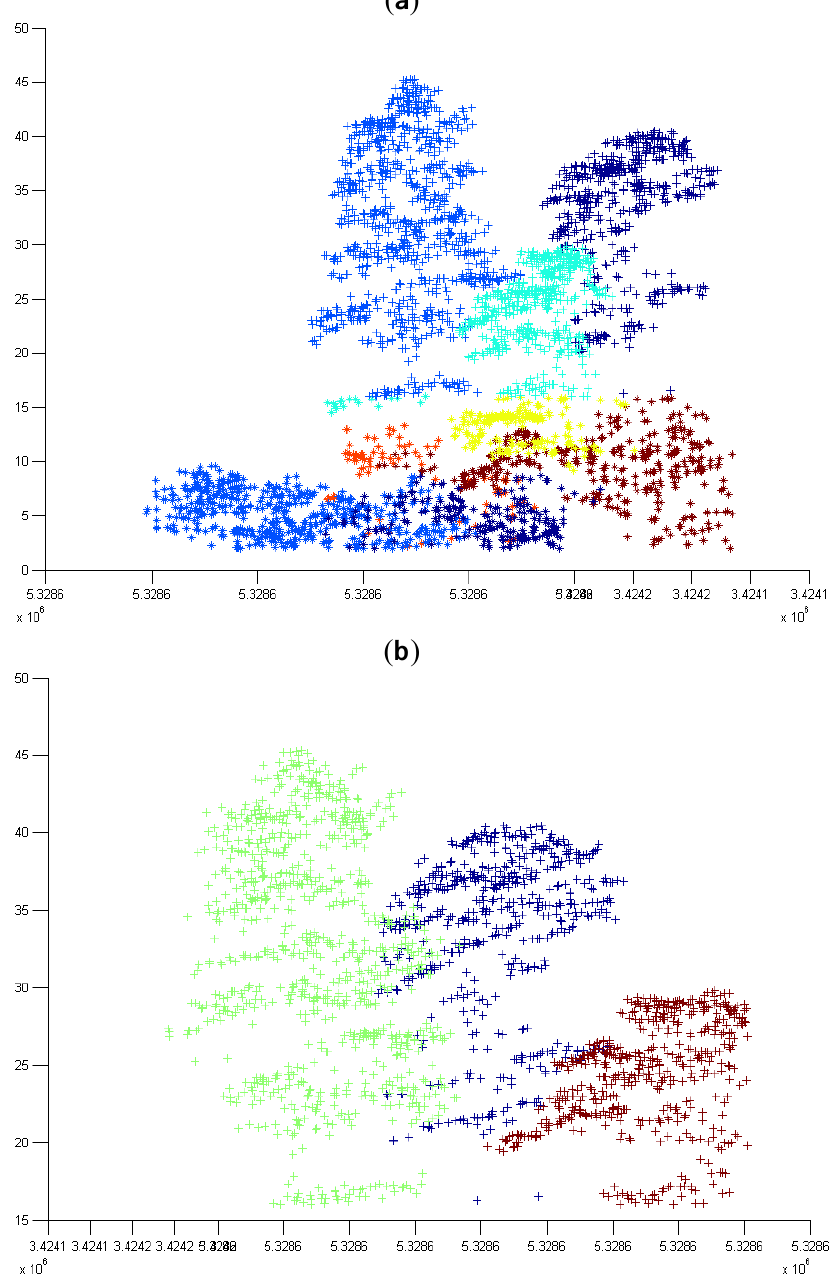
Figure 15. Result after running hierarchical tree clustering without scaling down the height value on two datasets of Cell 6 at different height levels. ( a ) Cell 6 clusters after hierarchical clustering in 2 height classes (between 2 and 16 m height and above 16 m height). ( b ) Cell 6 clusters after hierarchical clustering performed on dataset above 16 m height. The x and y coordinate values (in meters) are displayed horizontally and the z value (in meters) is displayed